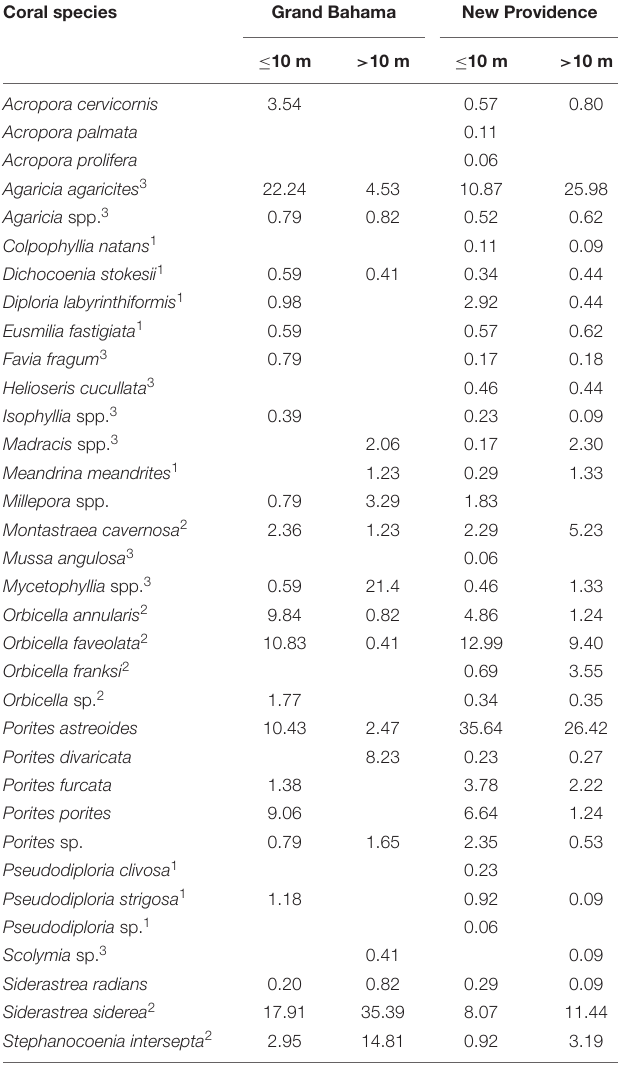
TABLE 1 | Percent composition of coral taxa observed for Grand Bahama and New Providence (The Bahamas) from 2019 AGRRA surveys for shallow ( ≤ 10 m) to deep ( > 10 m)